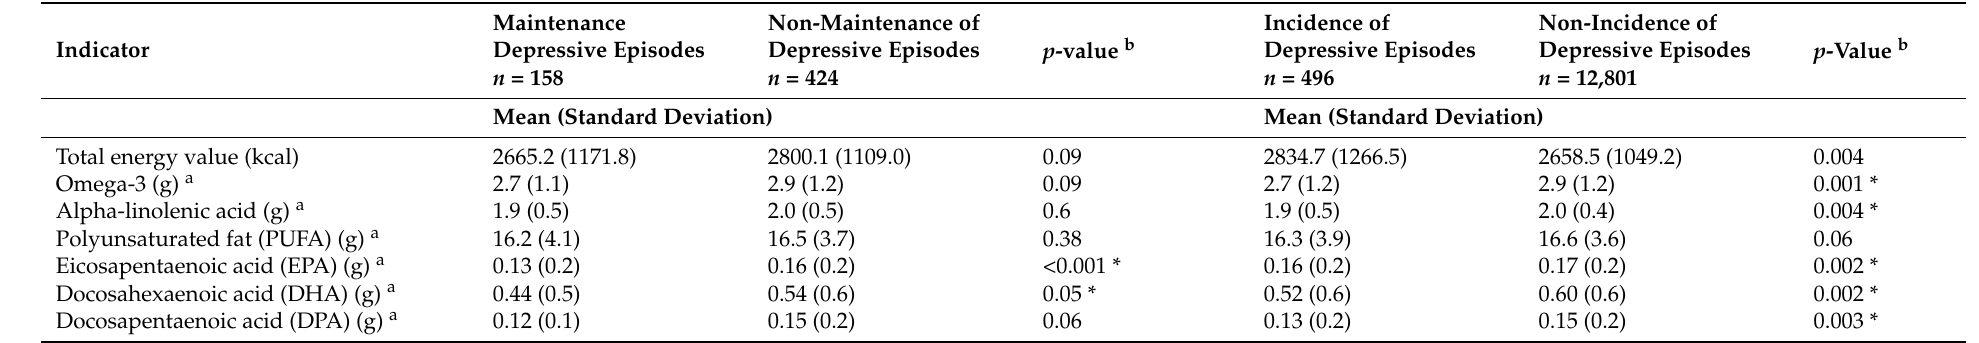
Table 2. Mean daily dietary intake by participants with/without maintenance of depressive episodes and with/without incident depression in the ELSA-Brasil Study, 2008–2010 (baseline) and 2012–2014 (first follow-up